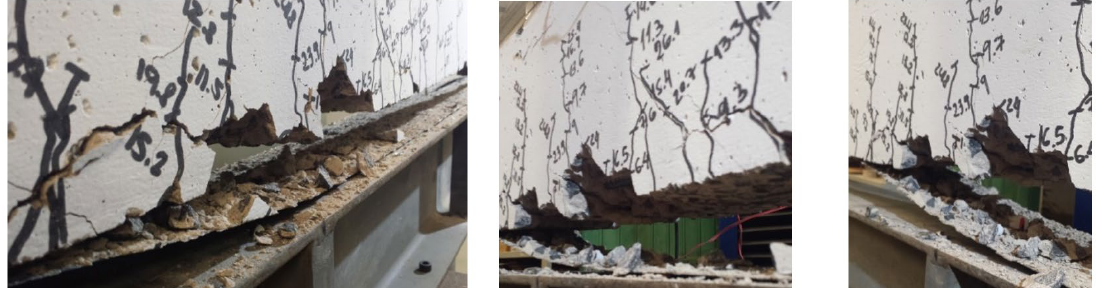
Figure 17. Verified failure mode on the strengthened